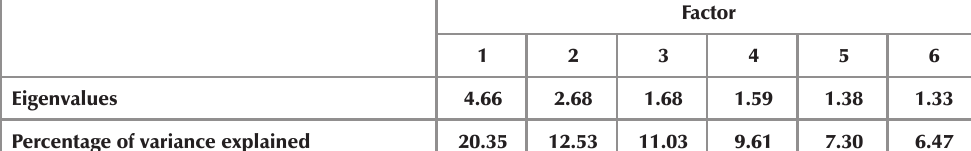
Rotated factor loadings* and factor scores of managerial responses to risk for sample commercial poultry farmers in the three zobatat of Eritrea, 2002/03